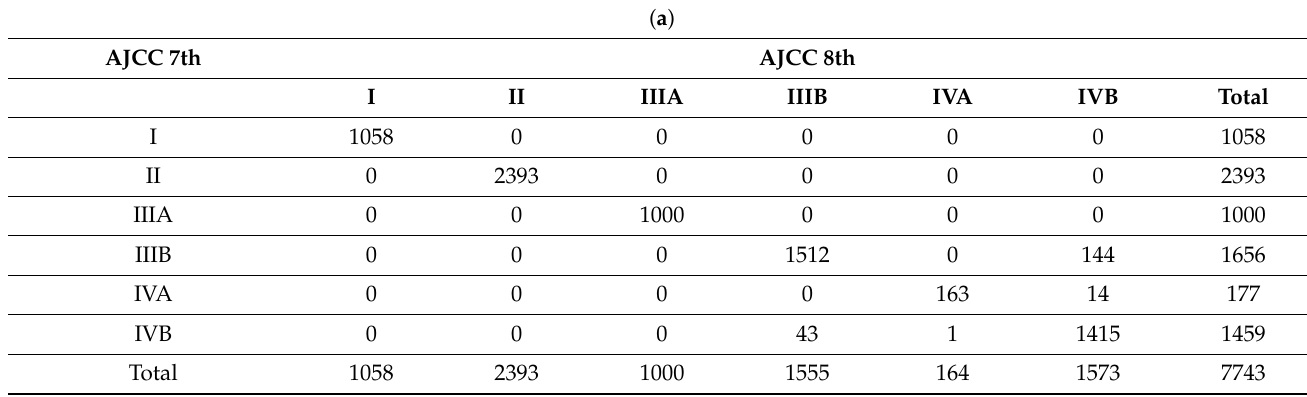
Table 2. ( a ) AJCC 8th vs. 7th classification of GBC patients from the National Cancer Database (NCDB). ( b ) GBC patients from the NCDB database: population